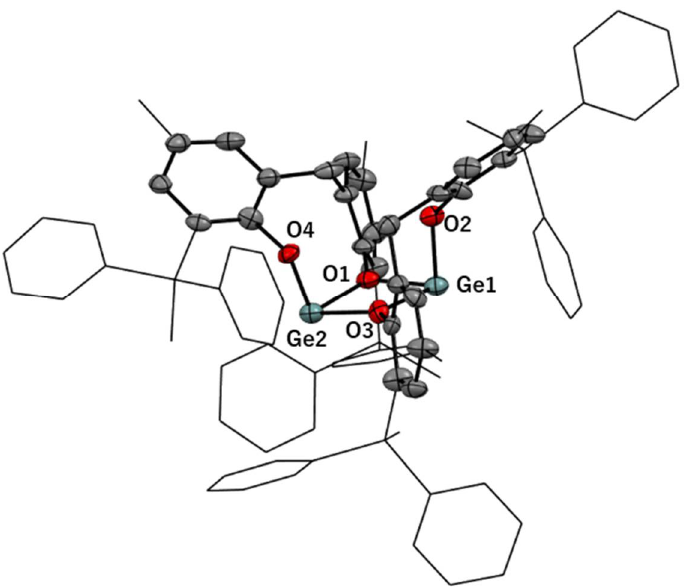
Figure 2. Solid-state structure of 3b with thermal ellipsoid plots at 50% probability. All hydrogen atoms are omitted for clarity. The SiMePh 2 and Me groups are shown in wireframe.